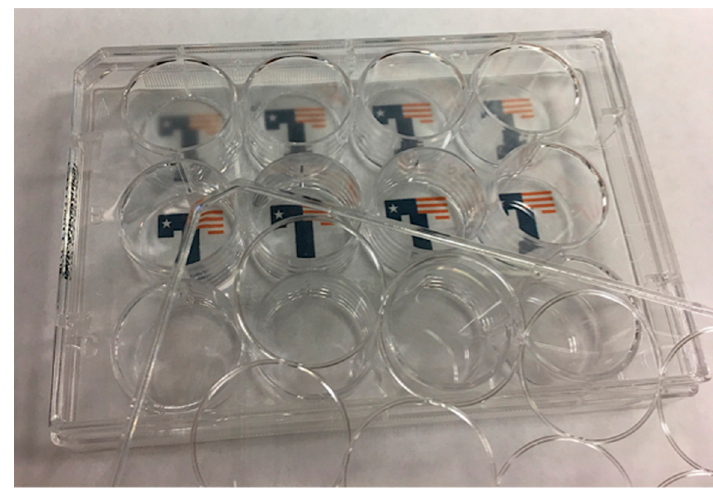
Figure 1. Physical appearance of the four polyurethane (PU) films: From left to right in the top wells, 200ET, 100ES, 60ES, and 60ET. The second row of four wells contains no PU films for comparison of the transparency of the PU films.